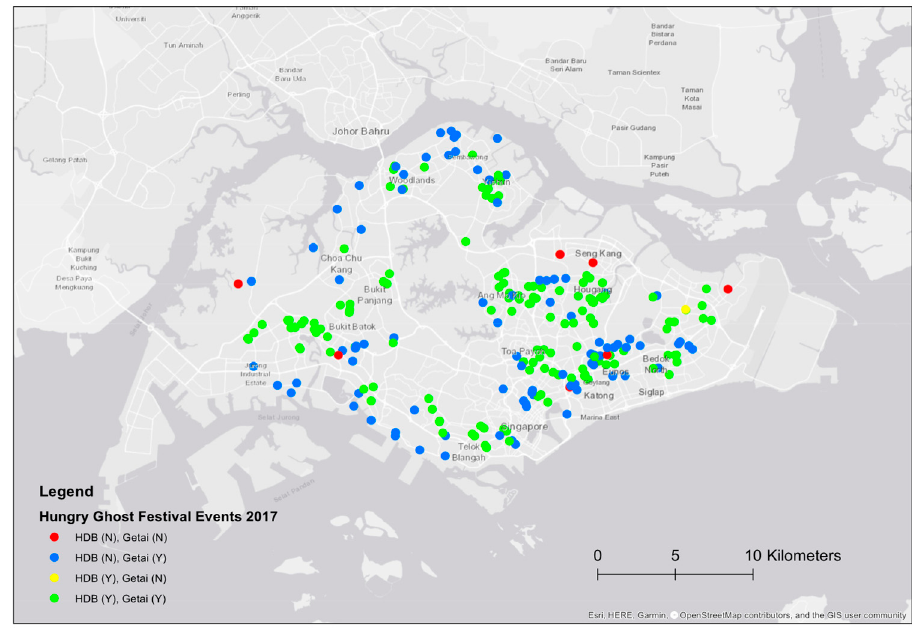
Figure 5. Distribution of Getai in 2017.